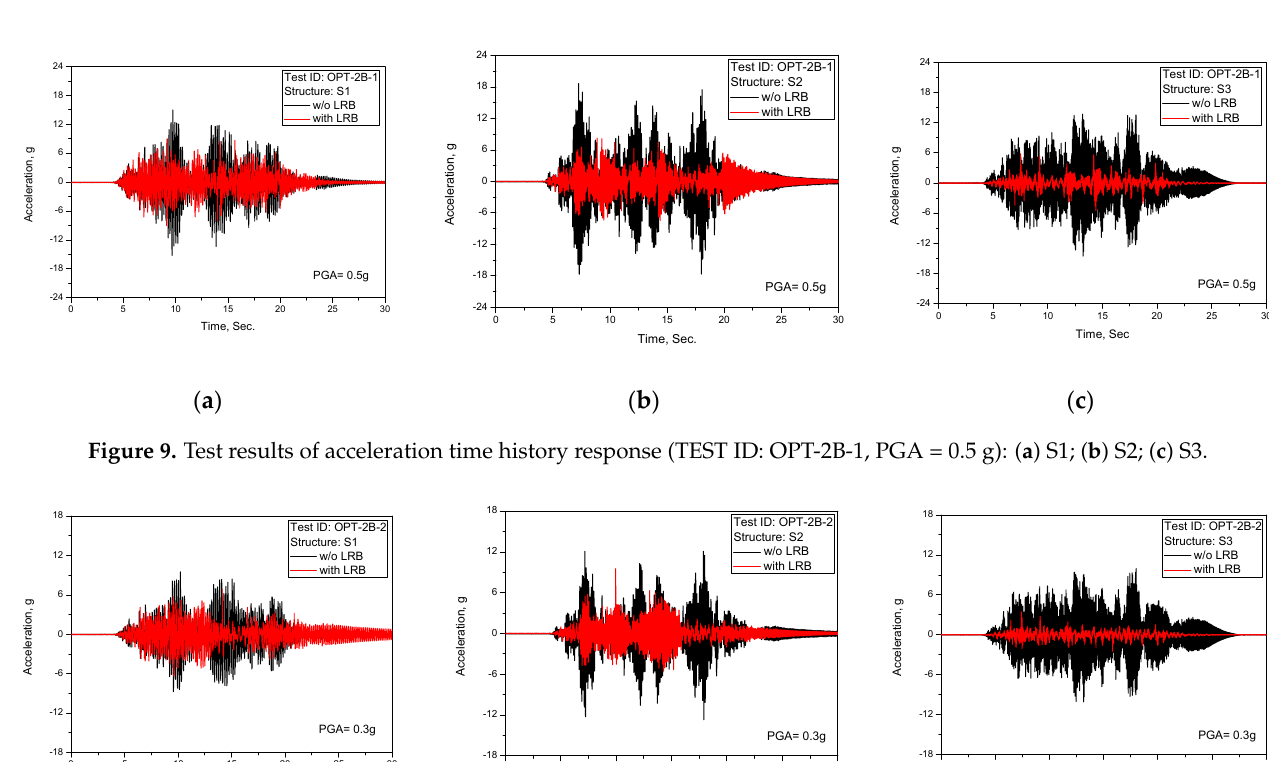
Test ID: OPT-2B-3 Structure: S3 w/o LRB